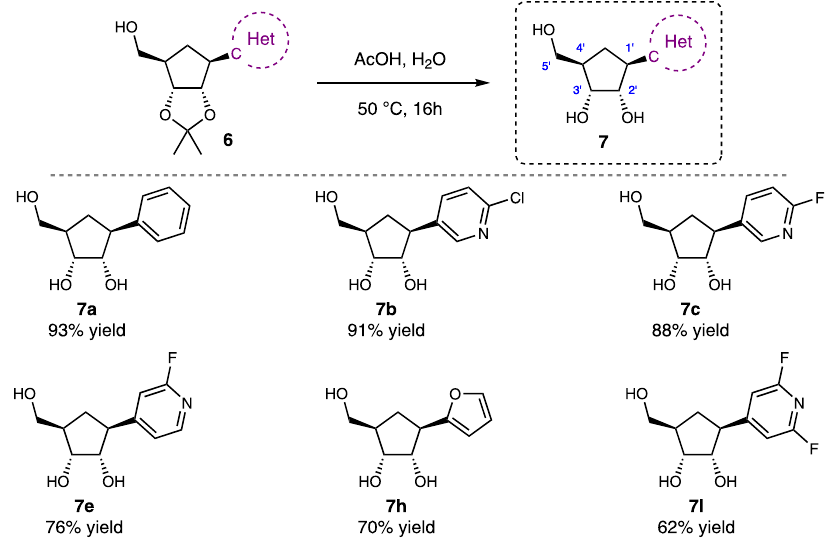
Fig. 6 Carbocyclic C-nucleosides bearing relatively simple ‘ nucleobase ’ moieties. Access toward simpler CC-Ns featuring phenyl, halo-pyridines, and furan